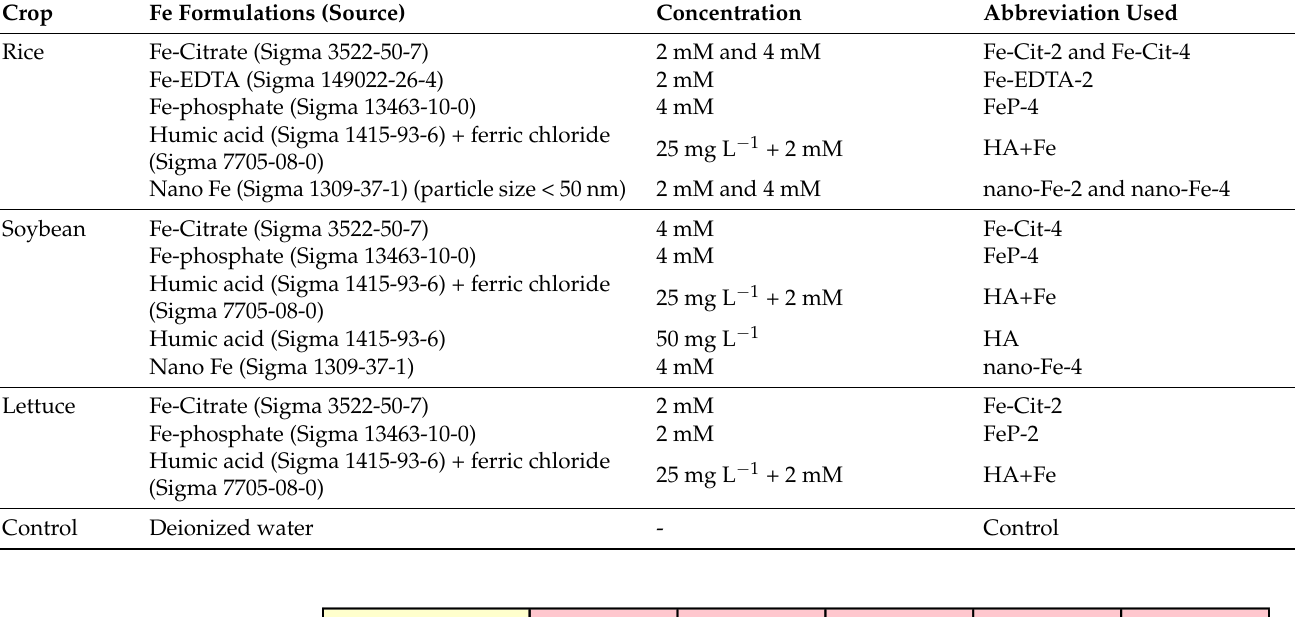
Table 1. Details of Fe formulations applied as foliar spray on rice, soybean, and lettuce in different growth stages.